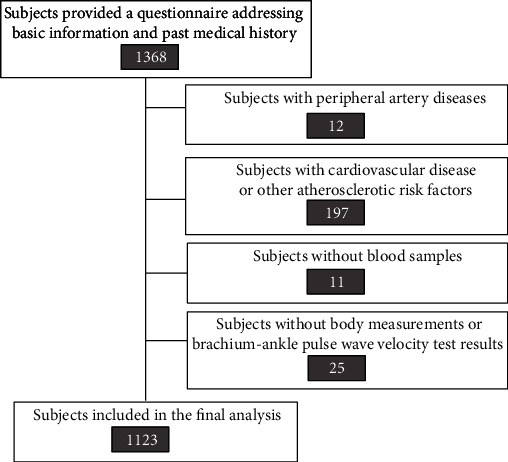
Flowchart of participant screening.